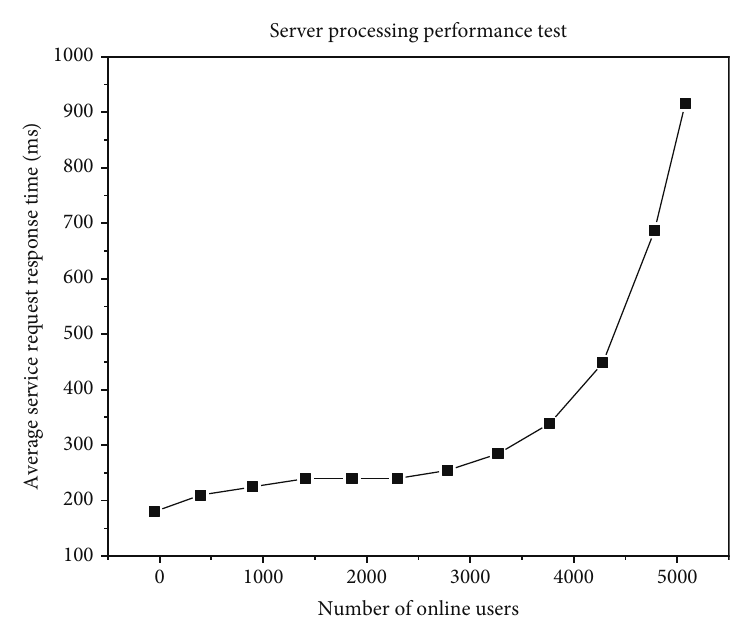
Figure 14: Analysis of server access performance test